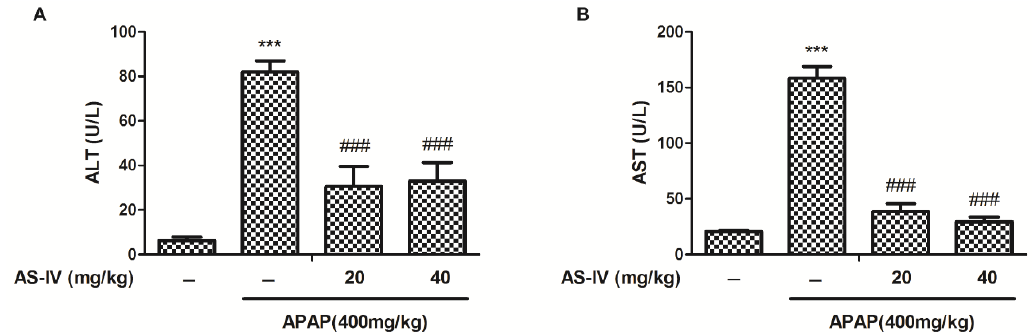
Figure 2. The AS-IV decreased APAP-induced increase in serum ALT ( A ) and AST ( B ) activities. Data were expressed as means ± standard error (SEM) ( n = 10). *** p < 0.001 compared to the vehicle control; ### p < 0.001 compared to APAP.